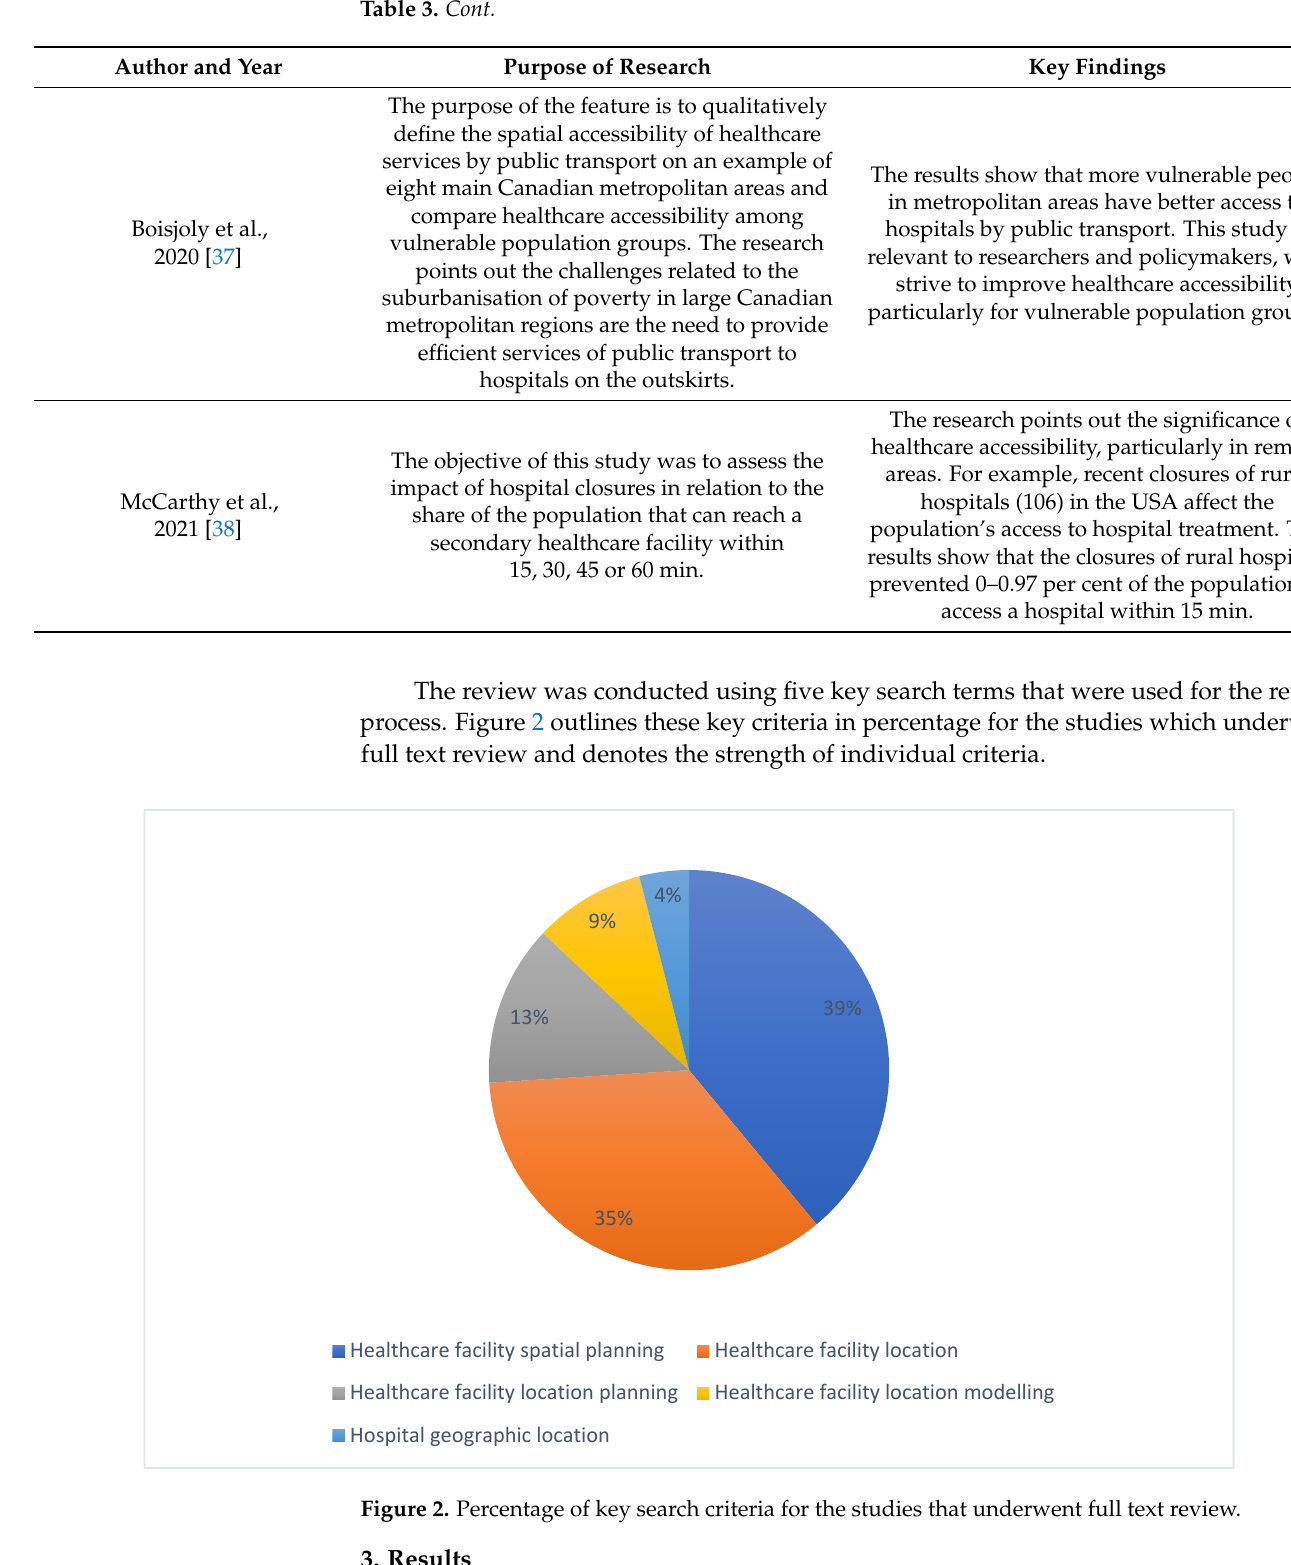
Table 4. Key themes involved in siting of healthcare care facilities. (X – Key theme alignment with individual study findings.).